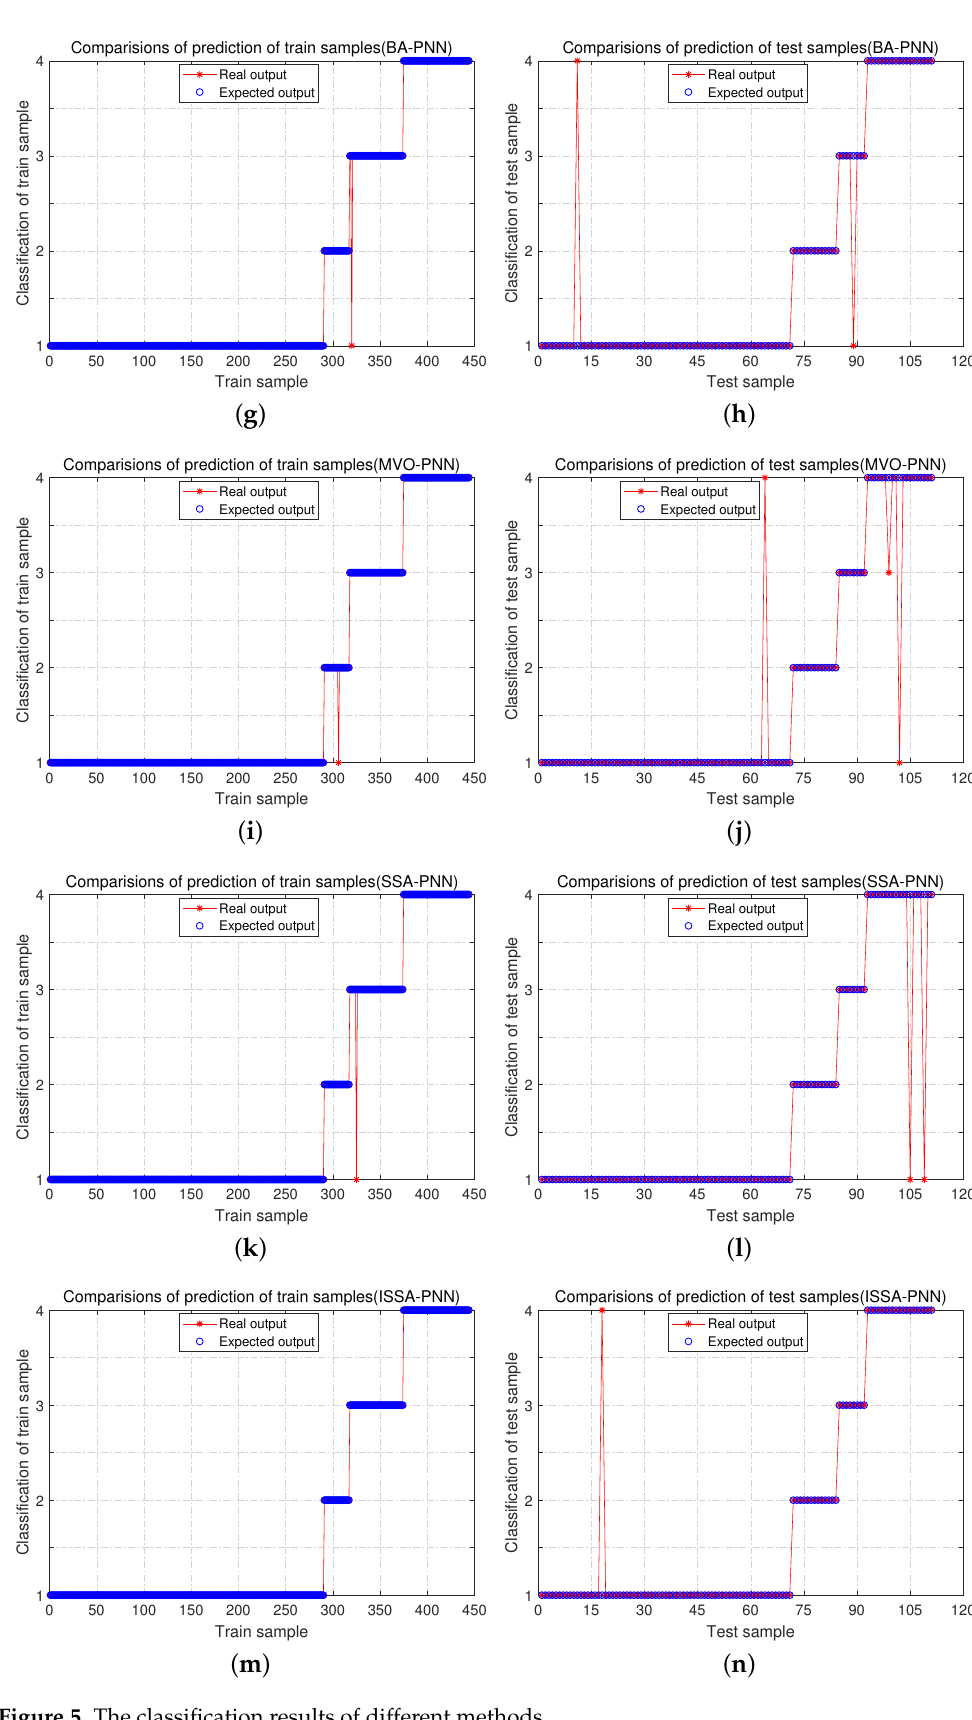
Figure 5. The classification results of different methods. The confusion matrix is one of the crucial tools for evaluating classification models. We plotted the confusion matrix of various methods to compare the performance of each